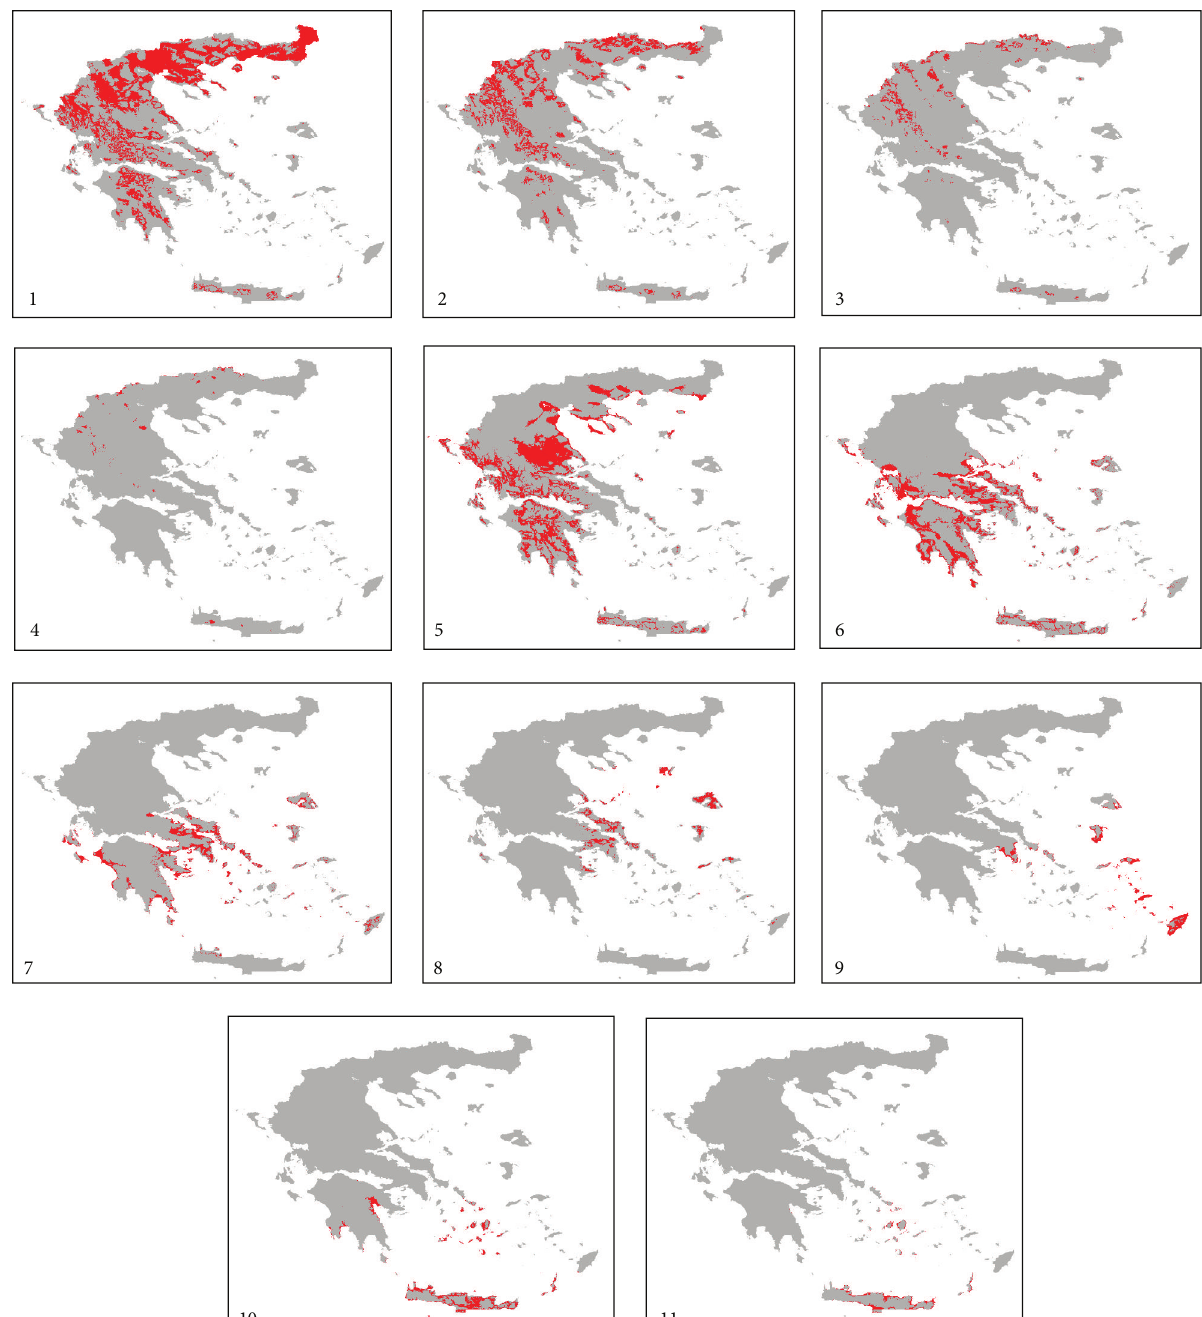
Figure 4: The spatial distribution of the 11 clusters of ET 𝑜 (on the bottom left corner of cluster figures are also given the CN values).